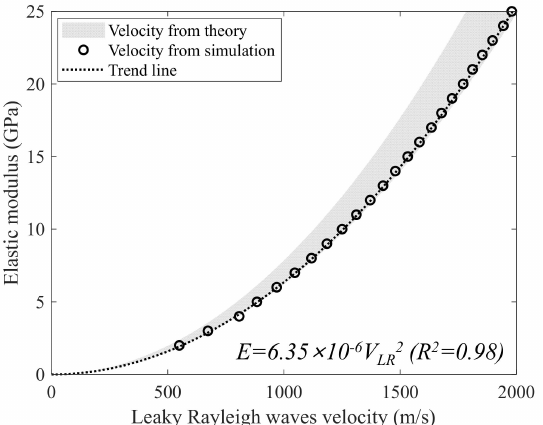
Figure 2. Derived relationship between the leaky Rayleigh wave velocity ( V LR ) and elastic modulus ( E ). Note that the range of theoretical Rayleigh wave velocity was calculated across the range of Poisson’s ratio (0.15~0.3) and mass density (2200~2600 kg/m 3